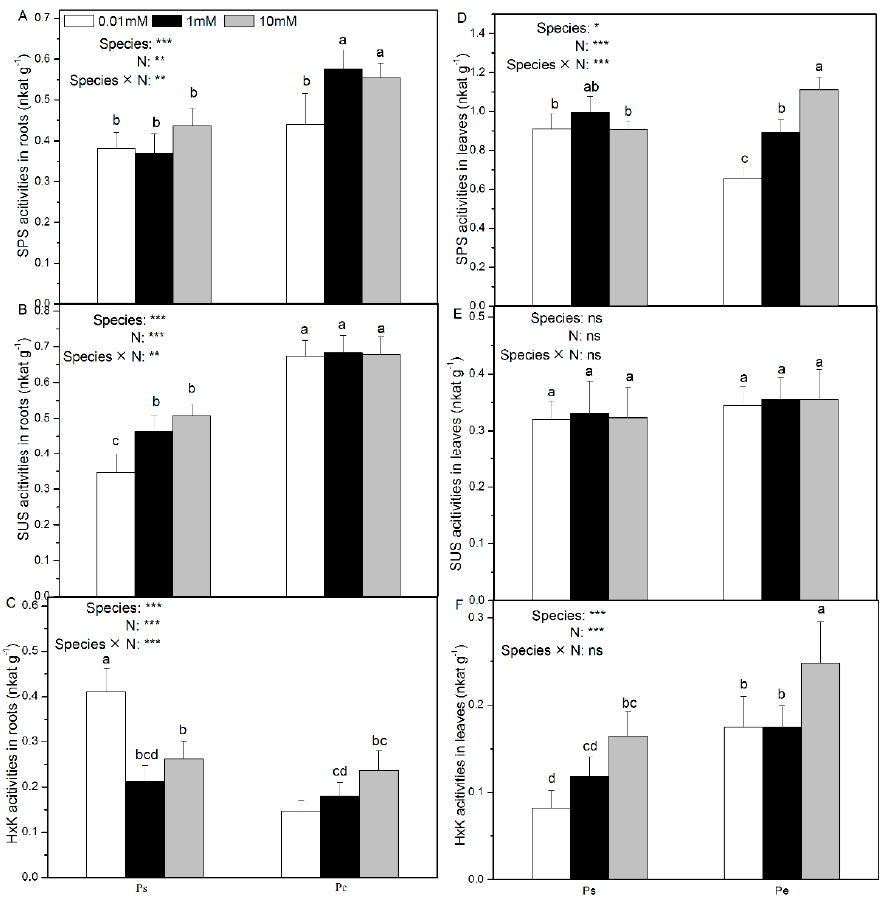
Figure 3. Sucrose phosphate synthase ( A , D ), sucrose synthase ( B , E ), and hexokinase ( C , F ) activities of P. simonii (Ps) and Populus euramericana (Pe) under 0.01, 1, and 10 mM NH 4 NO 3 . Bars labelled with different letters indicate significant difference between the treatments. p -Values of the ANOVAs of species, N treatment, and their interaction are indicated. * p < 0.05; ** p < 0.01; *** p < 0.001; ns, not significant.